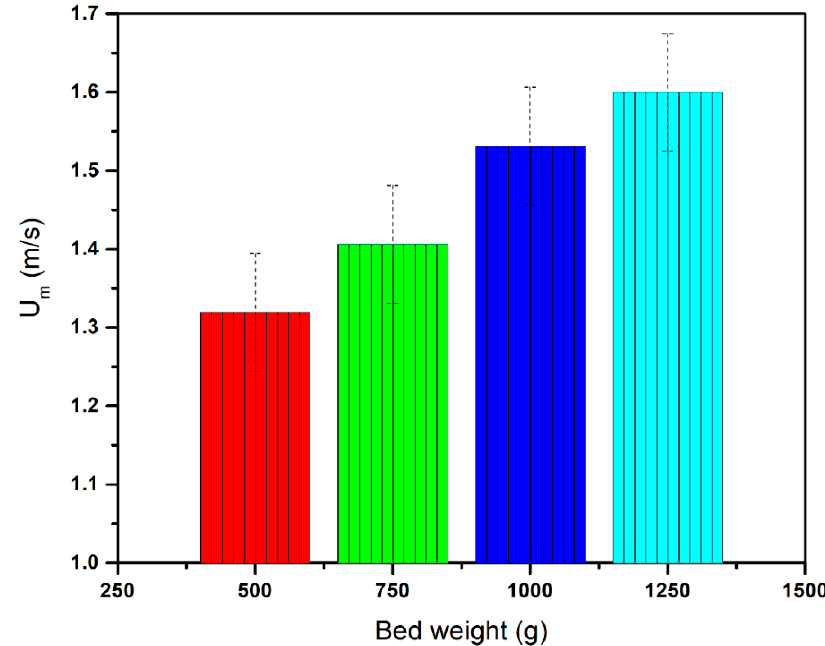
ff erent bed weights by fixing the blade angle at 60 ◦ . Processes 2020 , 8 , x FOR PEER REVIEW